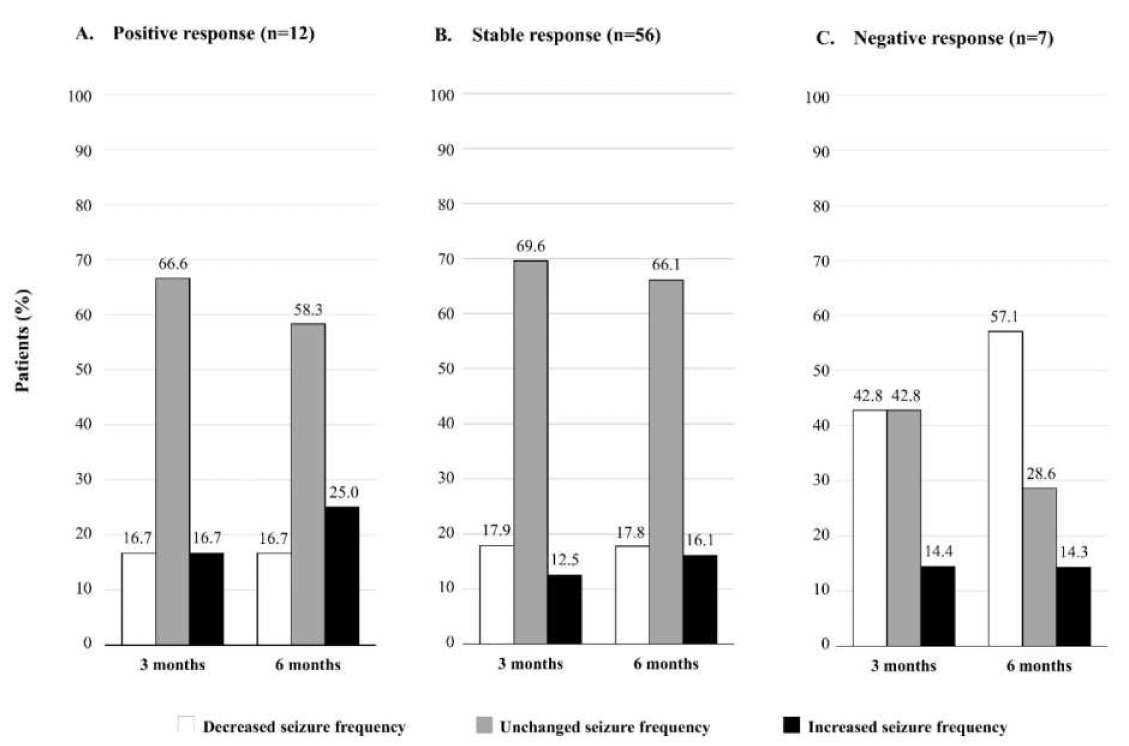
Figure 2. Changes in seizure frequency at three and six months after the levetiracetam substitu- tion with the generic drug in groups based on the initial response to treatment (positive, stable, and